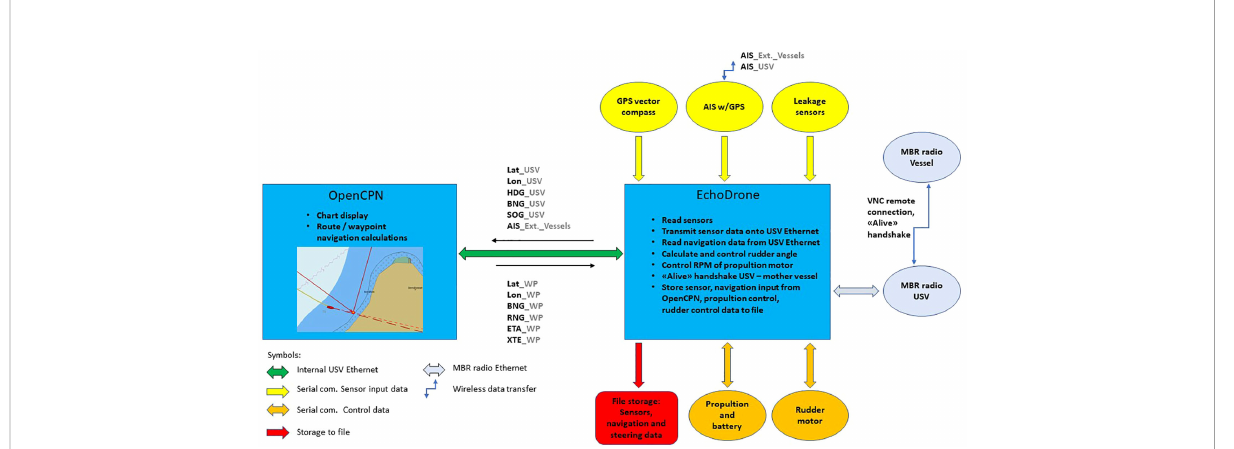
FIGURE 2 Overview of how the OpenCPN and EchoDrone programs share the task of controlling the Kayak Drone. The data fl ow between the two programs is shown as well as external sensors inputs and data outputs. Lat (latitude), Lon (longitude), HDG (heading), BNG (bearing), SOG (speed over ground), RNG (range), ETA (estimated time of arrival), XTE (cross track error), MBR (Maritime Broadband Radio), GPS (Global Positioning System) and AIS (Automatic Identi fi cation System), _USV (real time navigation data on the USV), _WP (navigation data on the active, next waypoint on the route), _Ext._Vessels (any vessel with AIS and withing